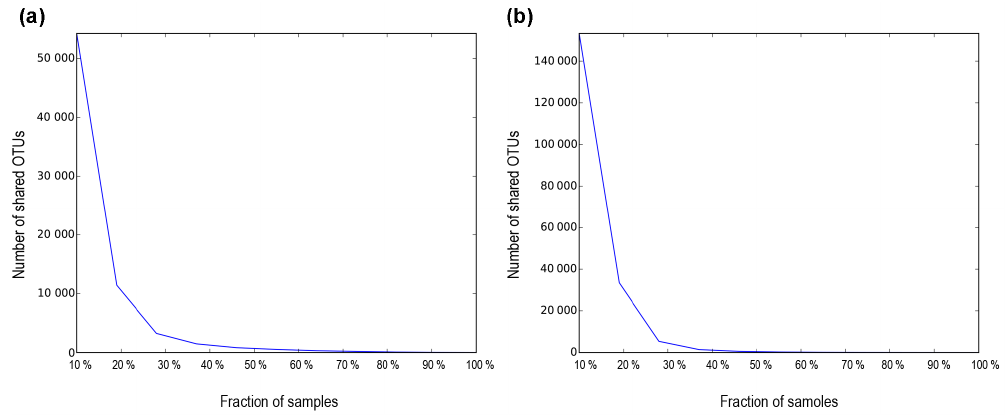
Figure 4. The number of shared (a) archaeal and (b) bacterial OTUs in the 12 different samples. The number of shared OTUs is shown on the y axis and the proportion of samples on the x axis.